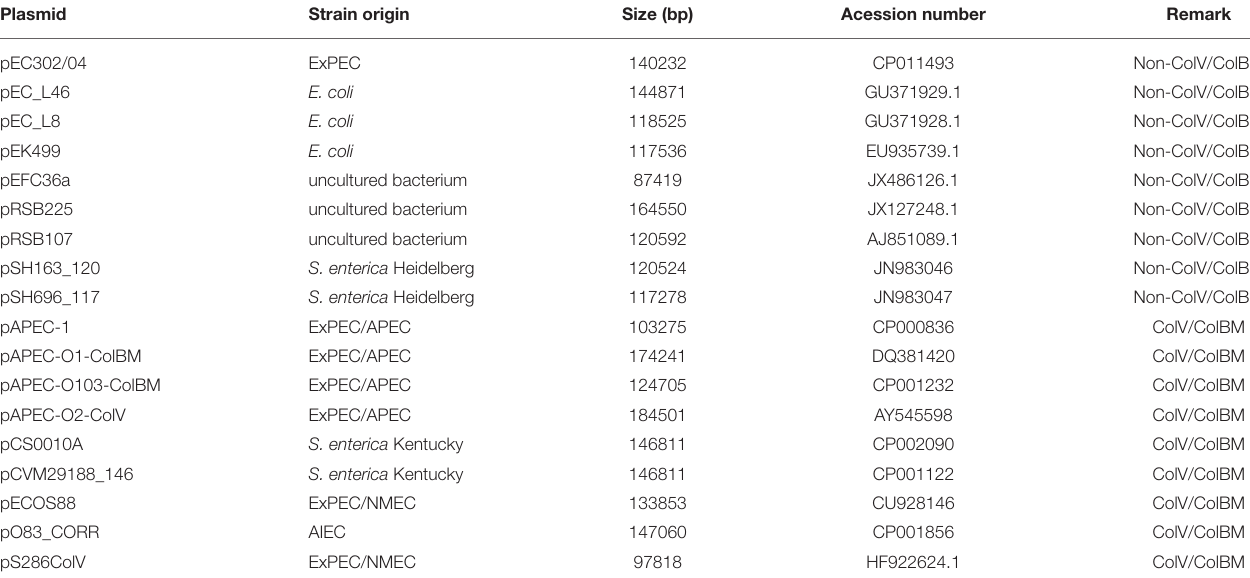
TABLE 1 | Information of the 18 IncF plasmids that are used in the comparative plasmid sequence analysis.